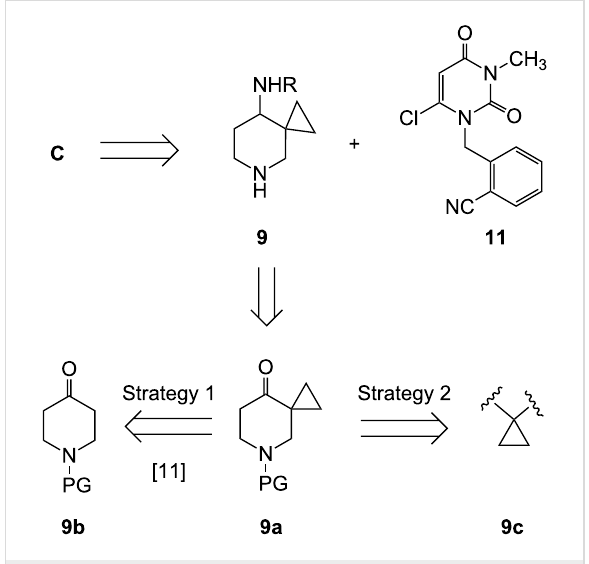
Figure 2: Strategy to prepare compound C (PG = protecting